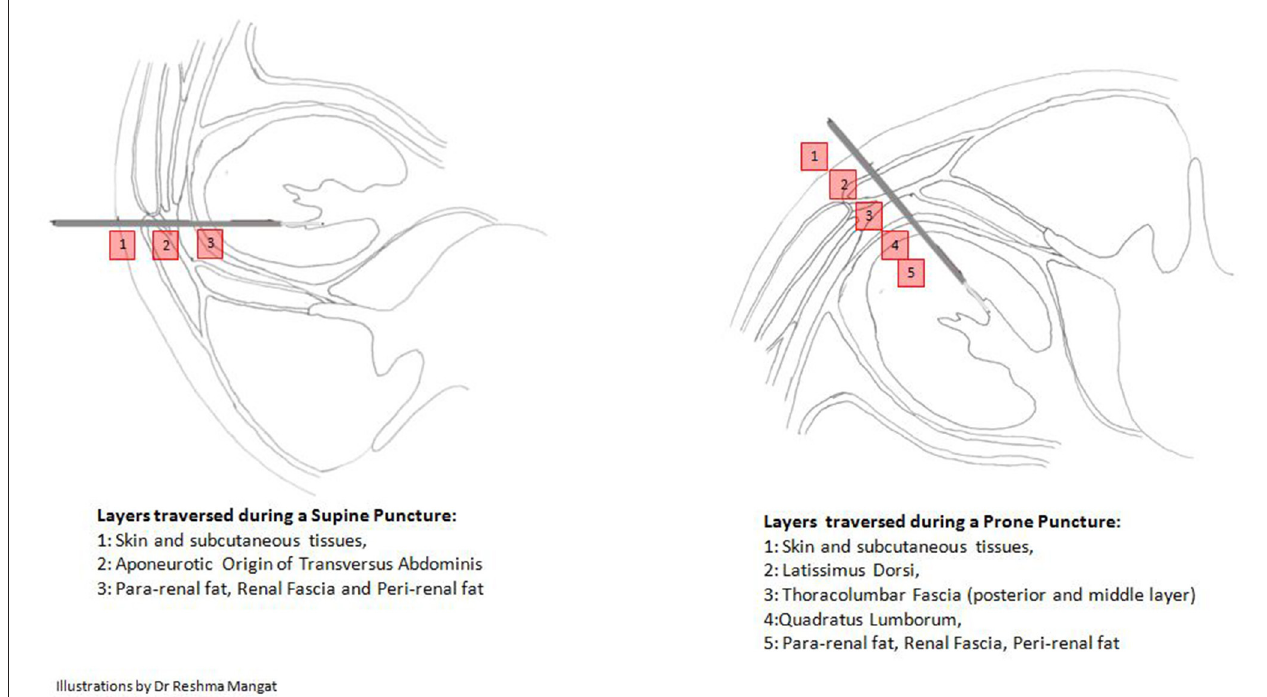
FIGURE 6 | The different fascias traversed depending on the approach of puncture.